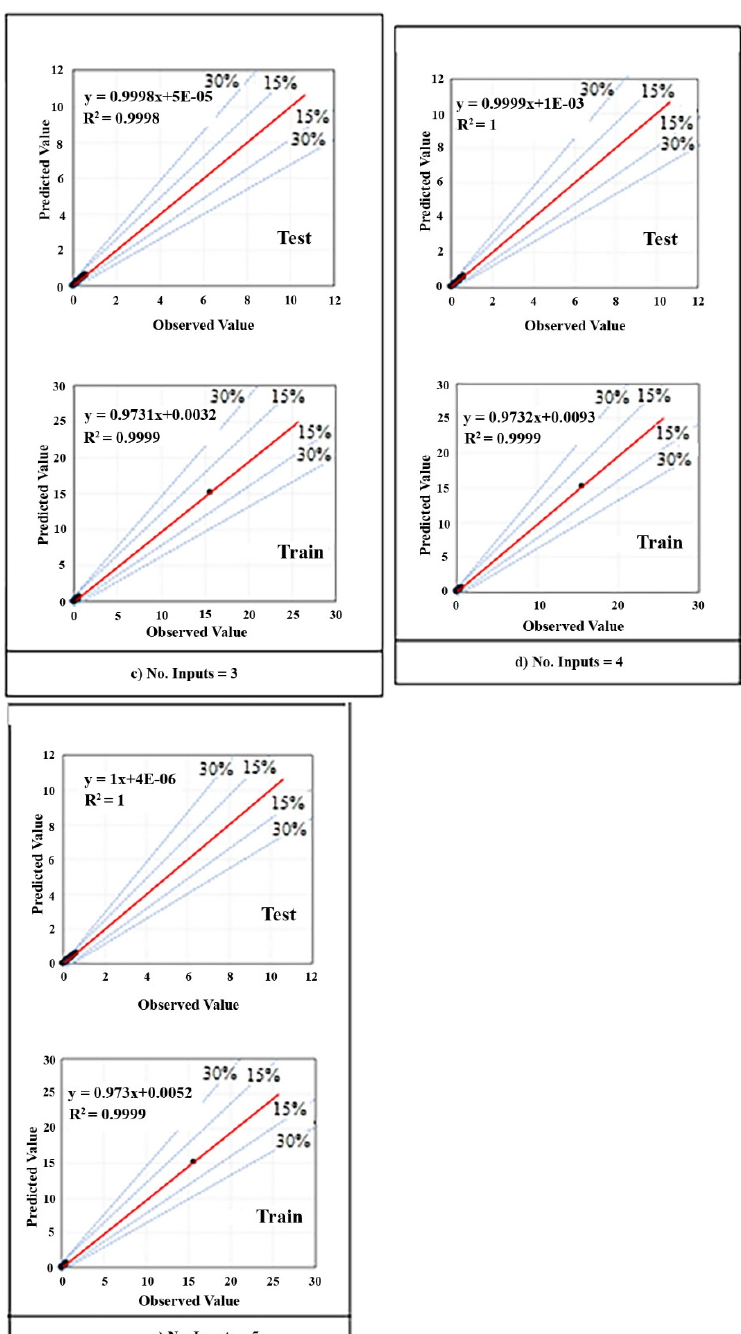
inputs; ( e ) five Figure 13. ANFIS regression diagrams: ( a ) single input; ( b ) two inputs; ( c ) three inputs; ( d ) four inputs; ( e ) five inputs.